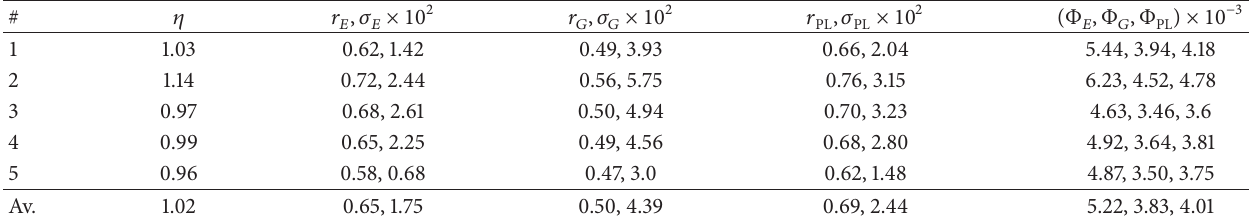
Table 2: Results of the fit of the extracted correlation functions for five patches and for the averaged correlation function (last row) by the exponential ( 𝐸 ), Gaussian ( 𝐺 ), and power law (PL) fitting functions, (8)–(10). For each fitting function the table shows the correlation radii 𝜎 , (7). The last column shows the calculated parameter Φ 𝑟 𝐸,𝐺, PL and the quality of the fits 𝐸,𝐺, PL [37] responsible for the exit neutron